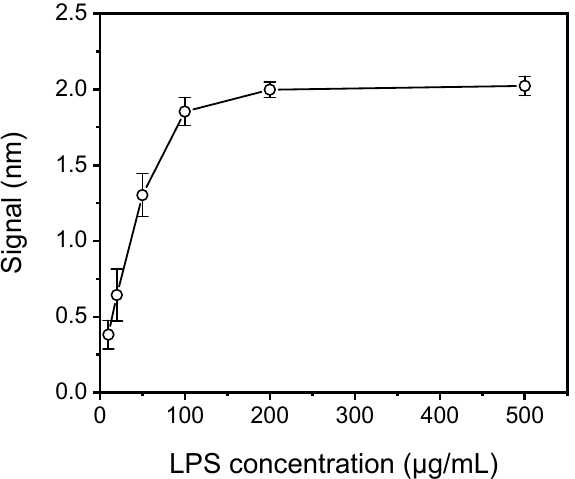
Figure 3. Plot of net mean signal values obtained for zero calibrator against S. typhimurium LPS concentration used for coating of the WLRS chips. Each point is the mean value of the signals obtained from five chips ± SD.